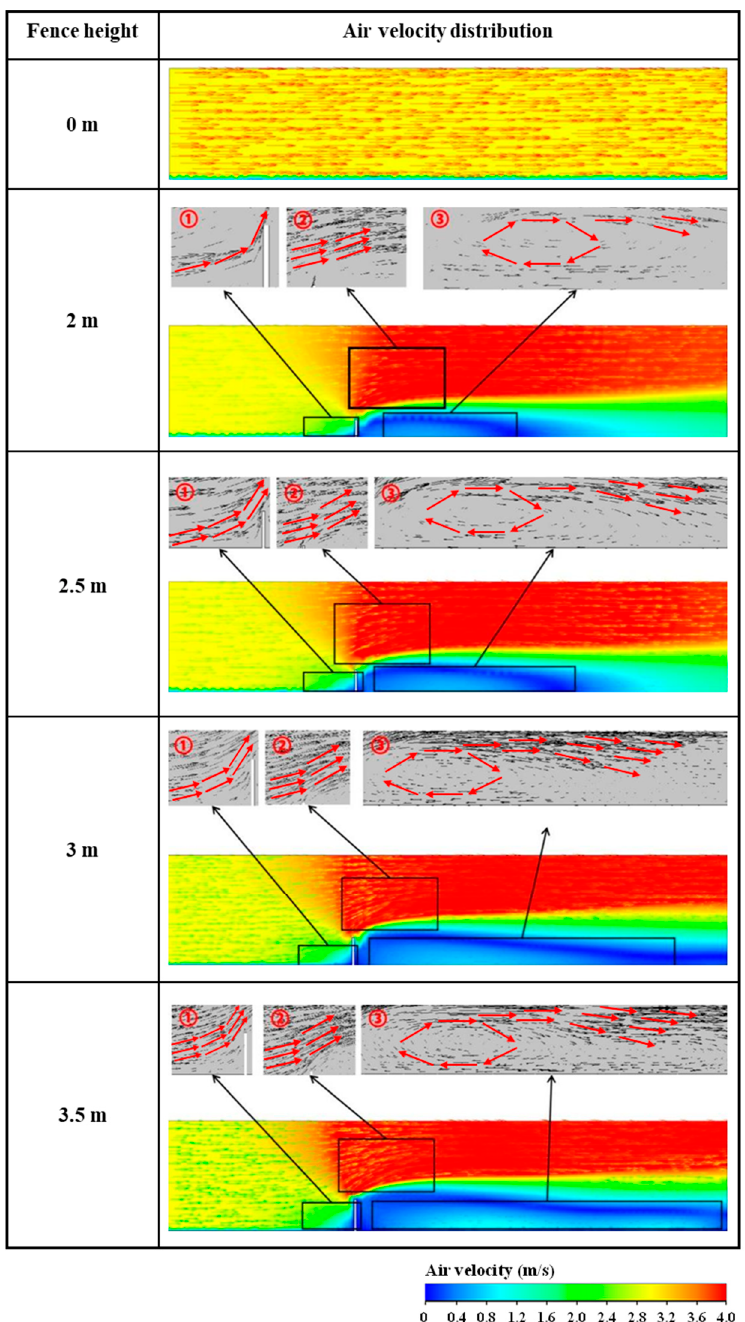
Figure 3. Distribution of airflow field velocity on construction and residential areas considering monitoring section S with five enclosure heights when initial horizontal wind speed is 3 m/s. ○ 1 is the updraft area; ○ 2 is the confluence area; ○ 3 is the vortex